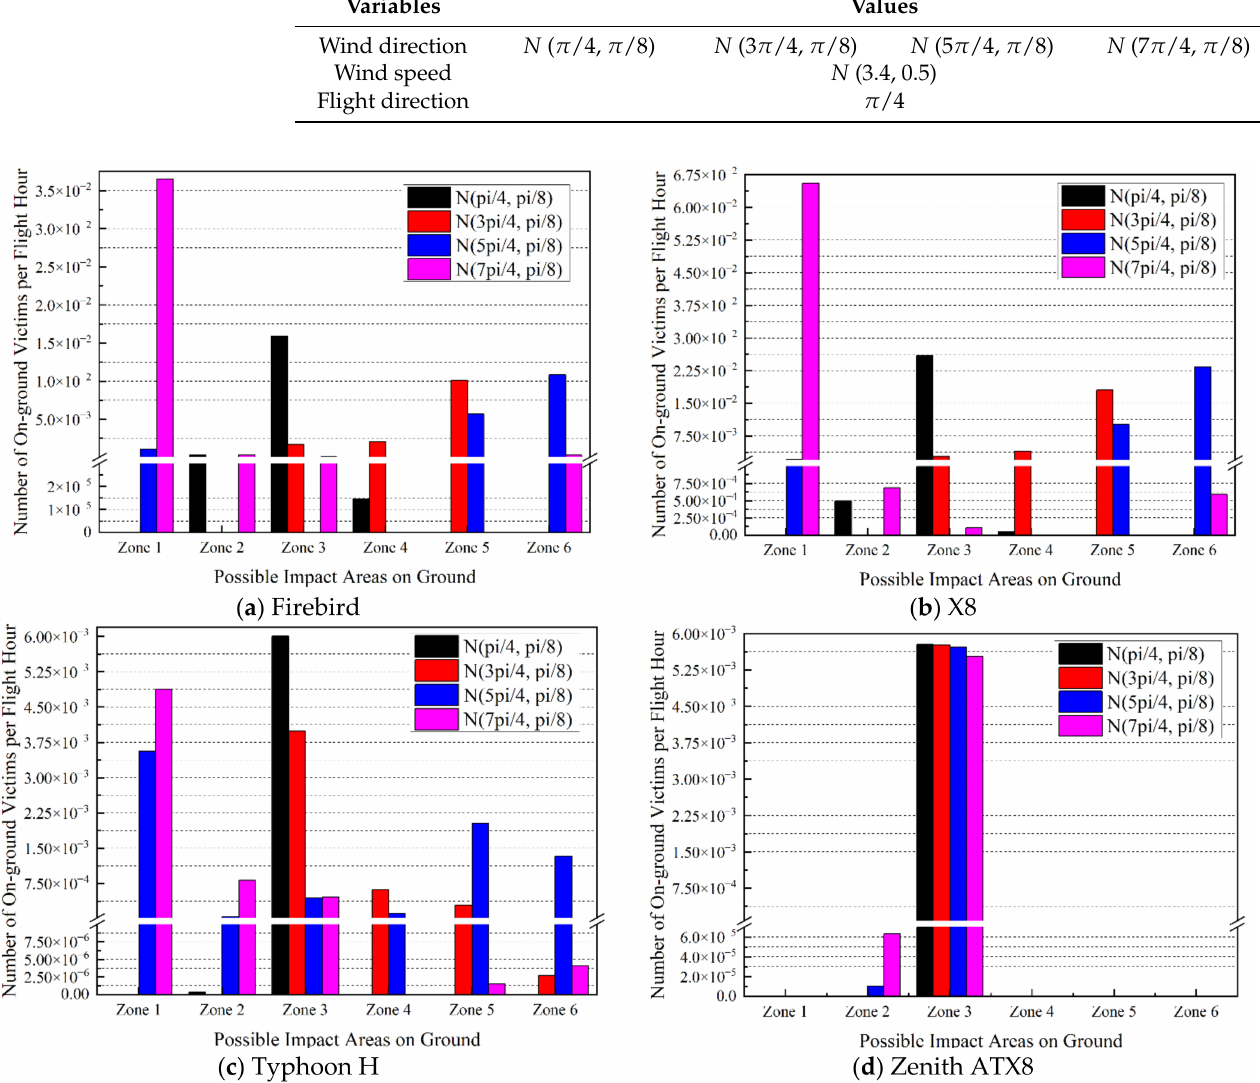
Figure 12. Ground fatalities with different wind